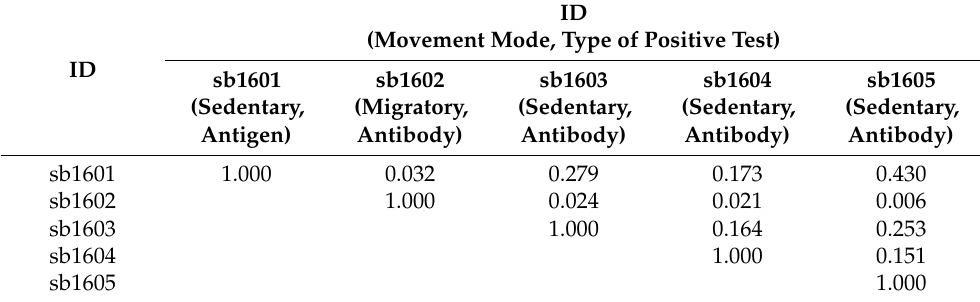
Table 3. Probability overlaps of the full utilization distributions of spot-billed ducks with highly pathogenic avian influenza H5N6 virus and H5-specific antibody (see Figure 3).